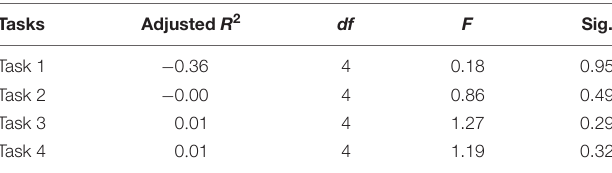
TABLE 4 | Relationship between the clustering metacognitive strategies and speaking performance across tasks. Tasks F Sig.